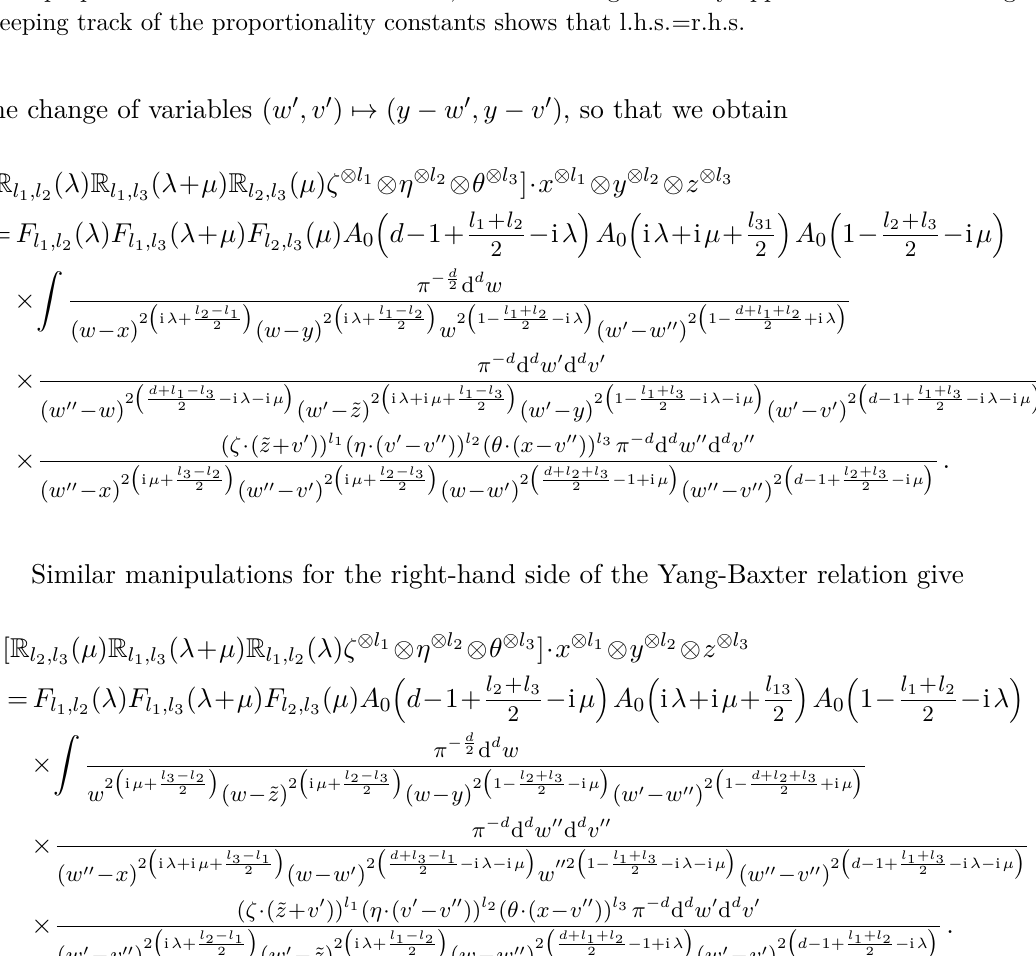
Figure 9 . The kernels depicted on the left and on the right are related respectively to the l.h.s. and r.h.s. of the Yang-Baxter equation (2.63) in the integral representation for the R-matrix ele- ments (2.3), and the equality of the two kernels is equivalent to the YBE. Both kernels are shown to be proportional to the one in the middle, via star-triangle identity applied to the blue